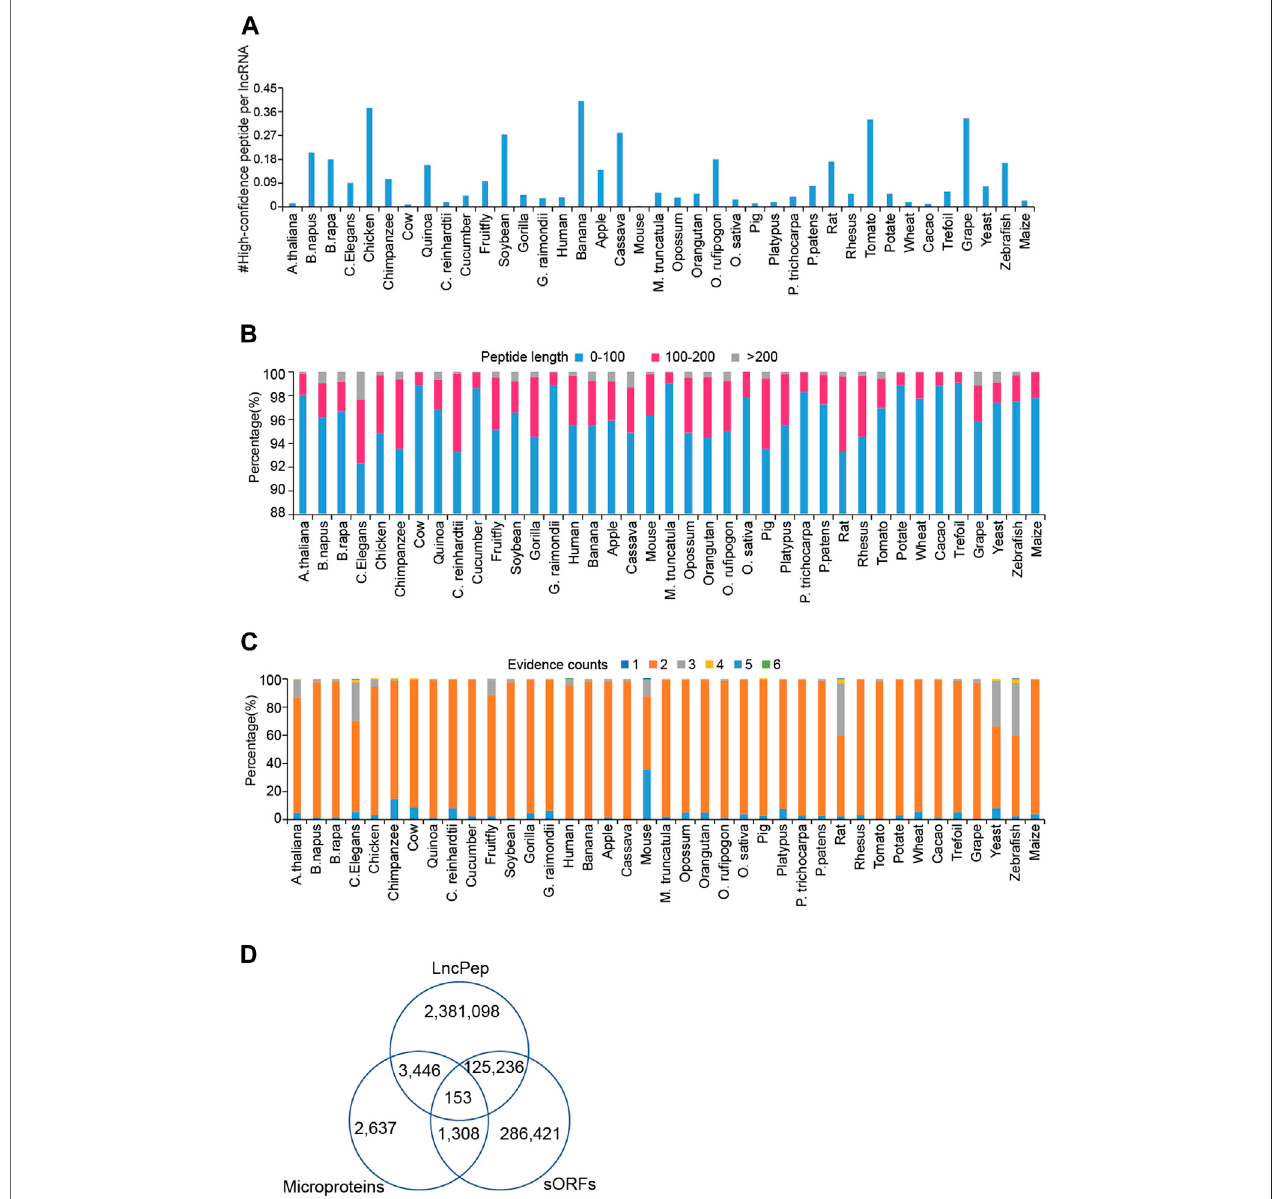
FIGURE 2 | Characterization of lncRNA-encoded peptides across different species. (A) The distribution of high-con fi dence ORFs per lncRNA across 39 species. (B) BarplotsshowthelengthdistributionoflncRNA-encodedpeptidesineachspecies. (C) Thedistribution ofsupportingevidenceoflncRNA-encoded peptidesacross different species. (D) The comparison of peptides among LncPep, sORFs, and Microproteins.